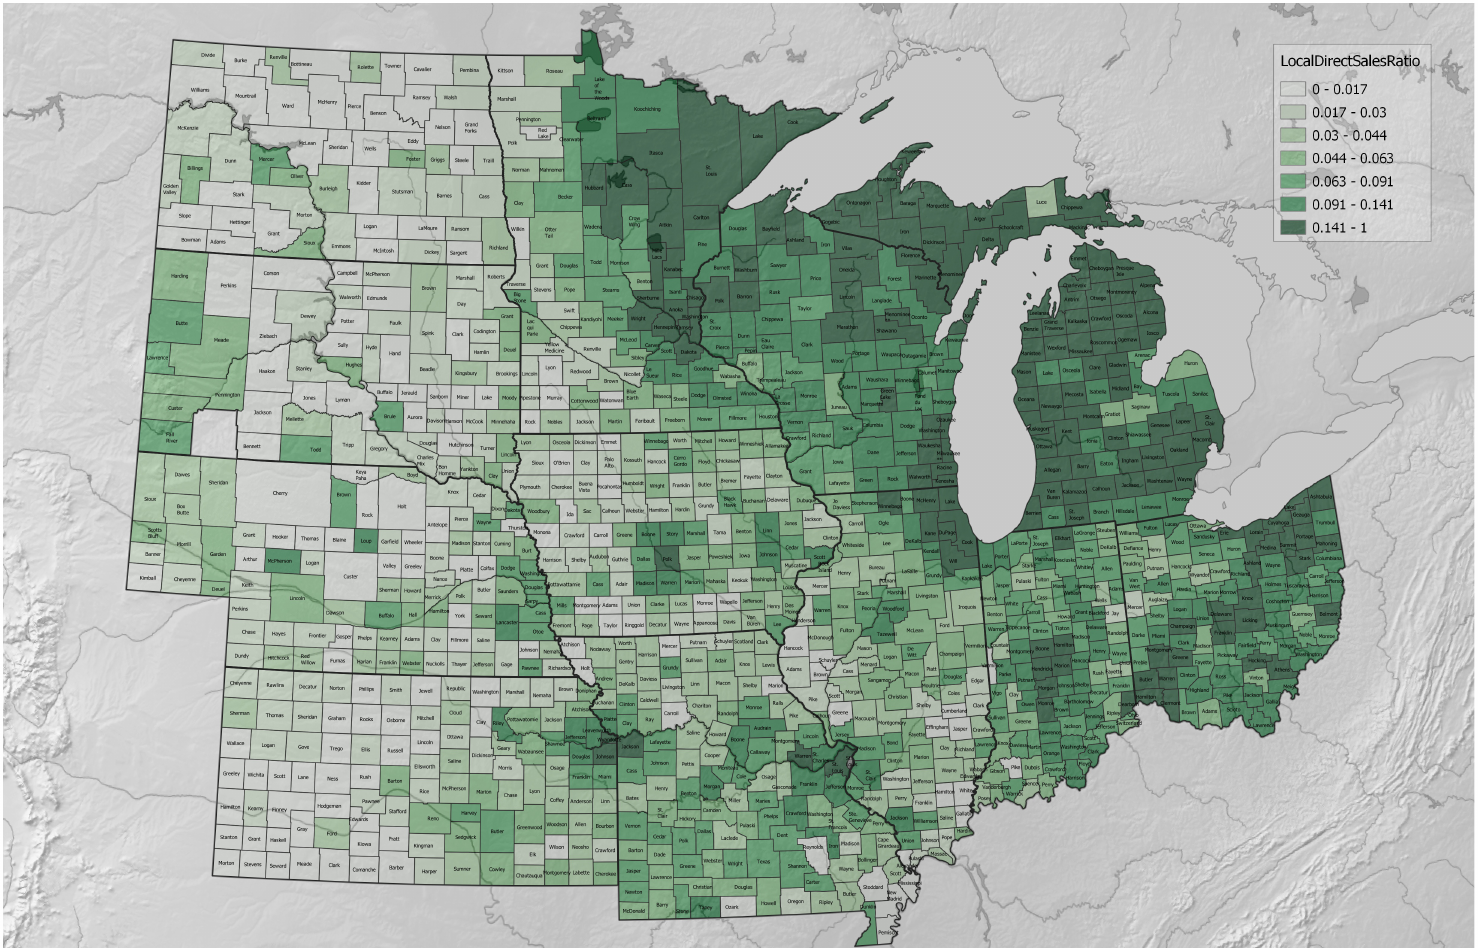
Figure A8. Fraction of farms selling direct to consumers, by county, 2017. Values were all rescaled through dividing by the largest value present for any of the counties included here (0.667 in Keweenaw County, Michigan), as this transformation was applied to the variable data as they were placed into the index expression. Methods for LocalDirectSalesFarmsRatio are described in the article main text and Supplementary Materials. USDA 2017 Census of Agriculture data [52] were